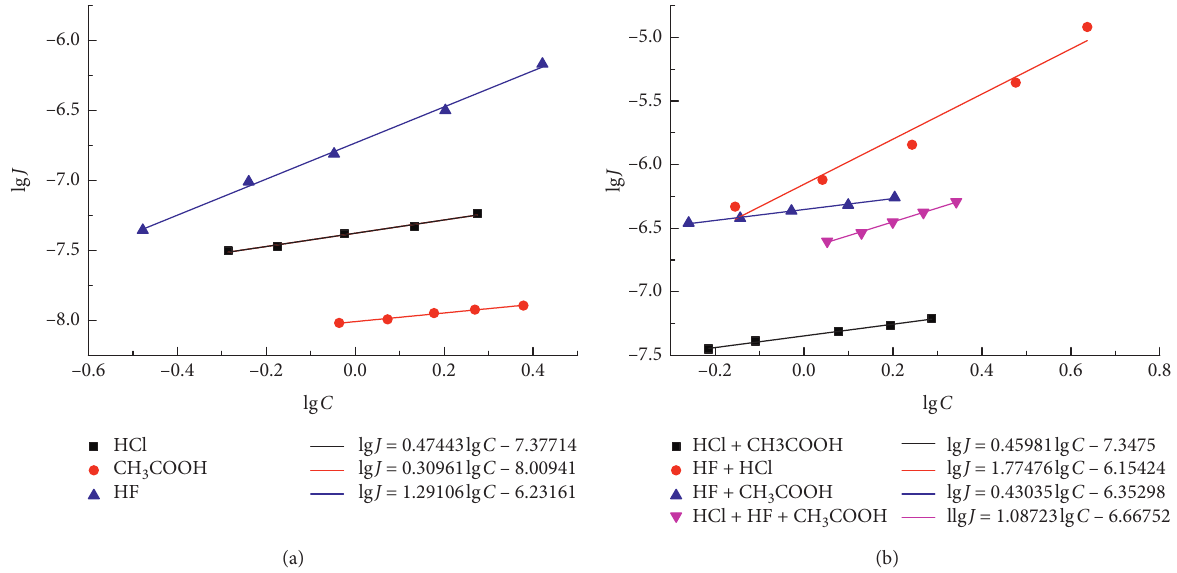
Figure 3: The relationship between the reaction rate of different acid solutions and sodium bentonite and the logarithm of multicomponent acid concentration: (a) logarithmic relationship between single acid and sodium bentonite; (b) logarithmic relationship between multi- component acid and sodium bentonite.